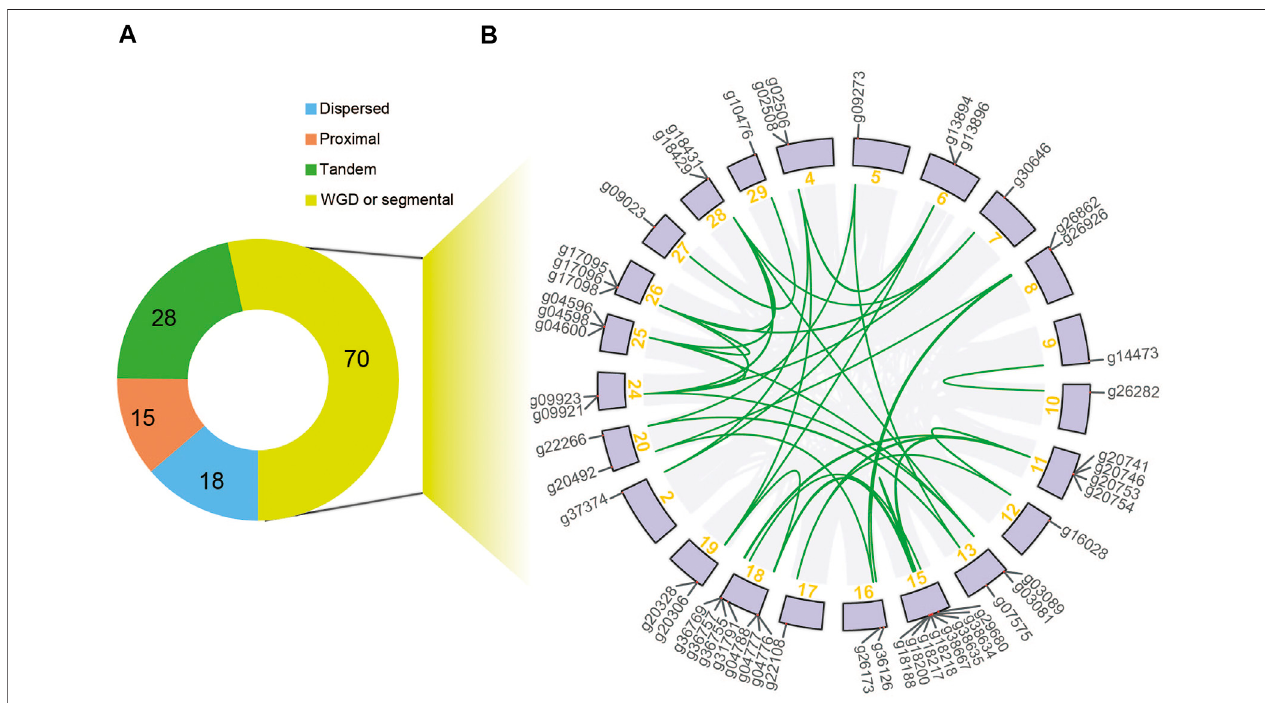
FIGURE3| Duplication type of E.feroxNBS-LRR genes. (A) Apiechart showing NBS-LRR geneswithdifferentduplication types. (B) Syntenic relationships ofthe 70 segmental-duplicated NBS-LRR